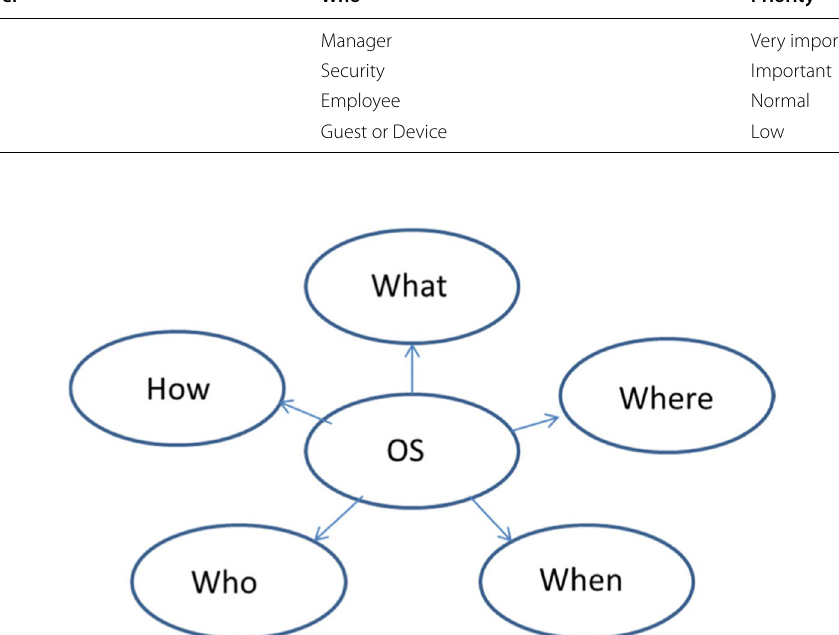
Fig. 6 The Objective of state description with 4W1H with five elements: